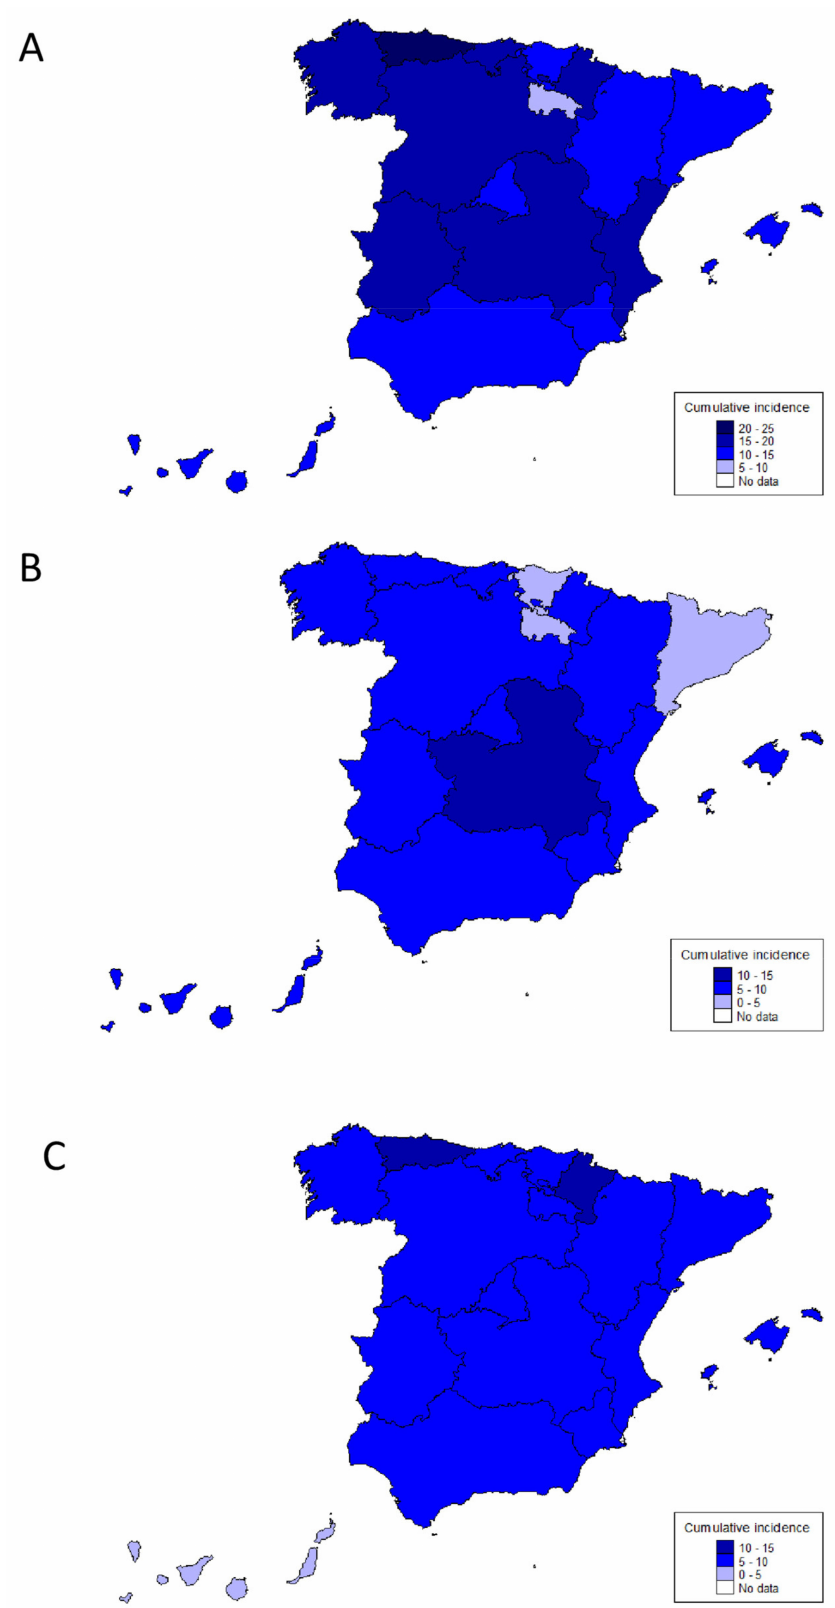
Figure 1. Incidence of inflammatory bowel disease ( A ), Crohn’s disease ( B ) and ulcerative colitis ( C ) by Autonomous Communities in Spain in 2017 (cases/100,000